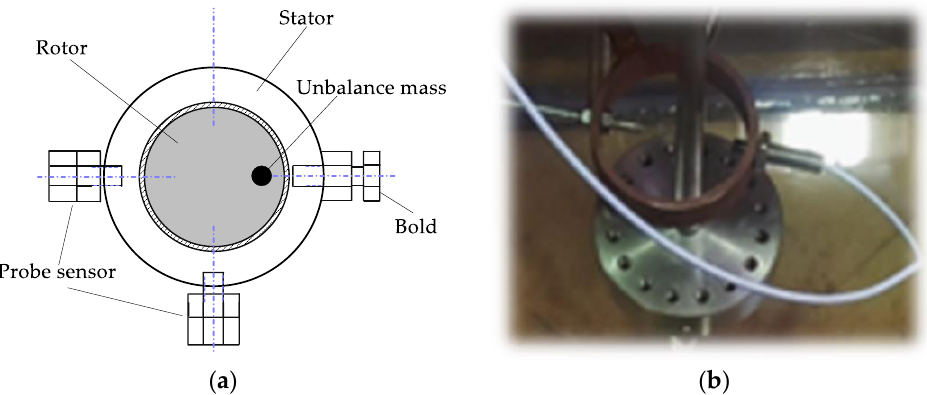
Figure 3. ( a ) Mechanical diagram of the rotor-to-stator contact simulator; ( b ) stator and probe mount.